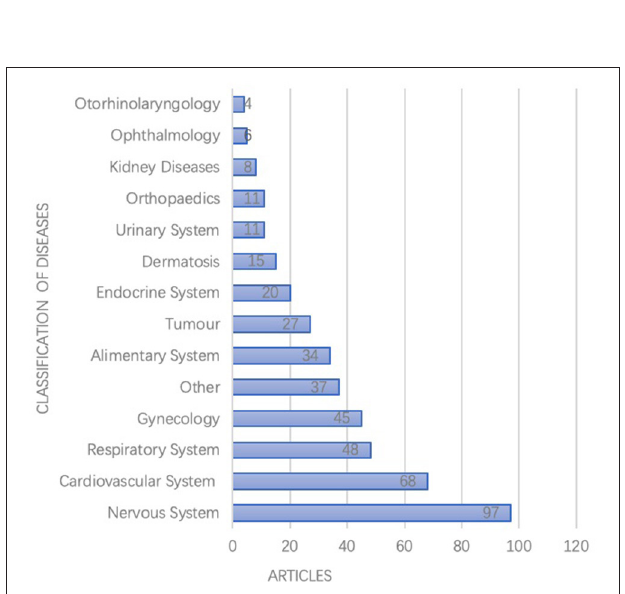
FIGURE 3 | Disease therapies for included pharmacoeconomics researches ( N = 434).